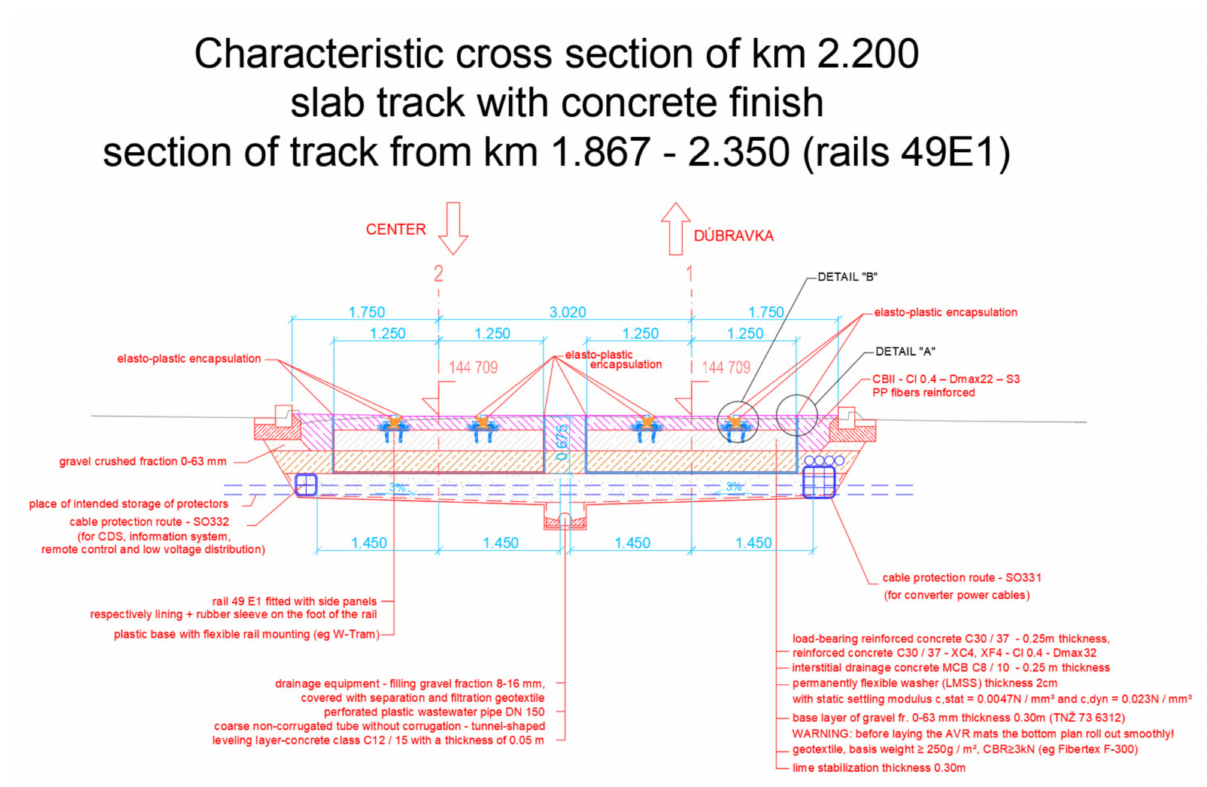
Figure 4. Schematic cross-section of the tram line structure outside the bridge structure